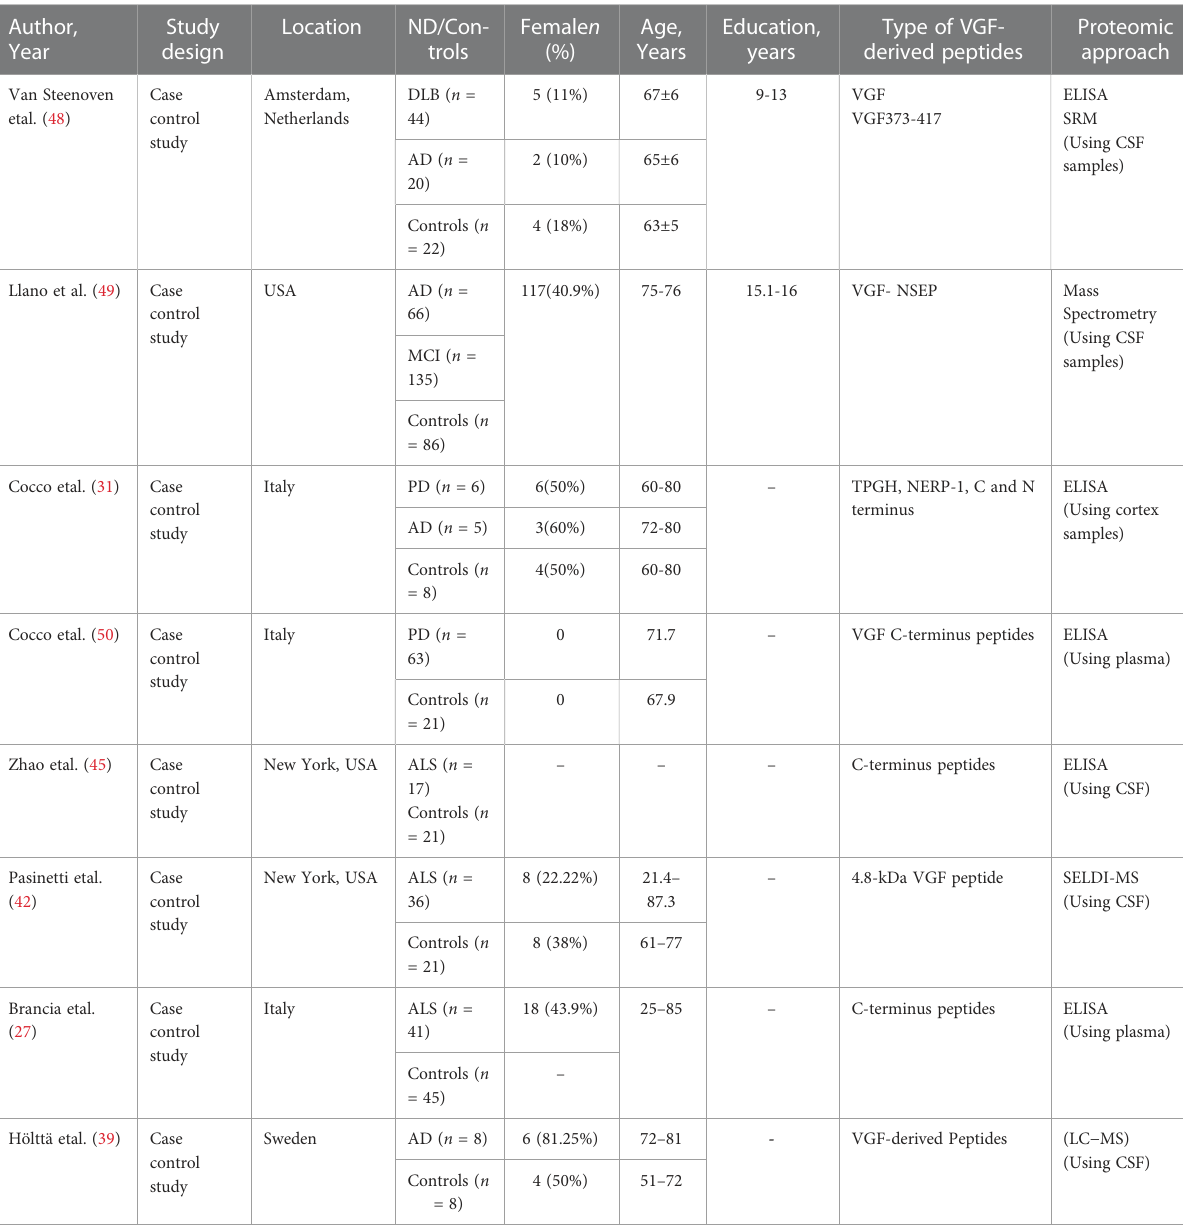
TABLE 5 Characteristics of the included